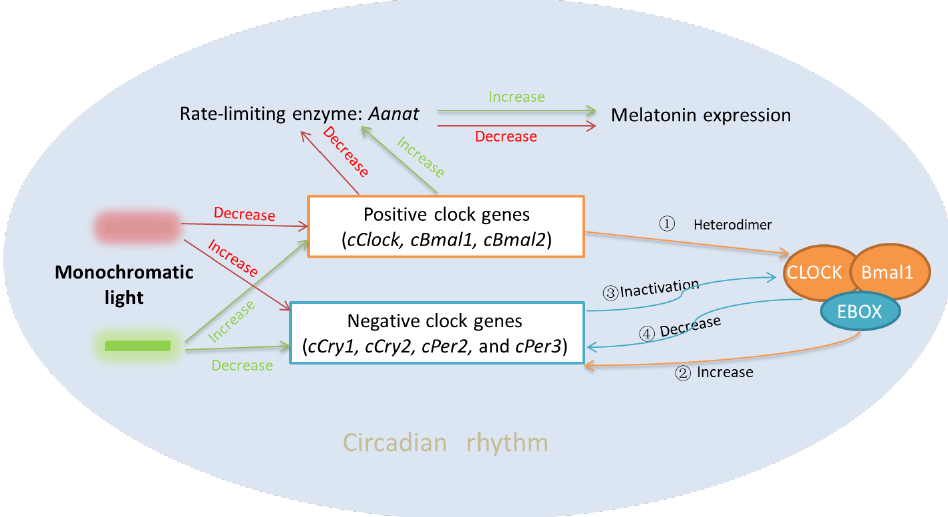
Figure 6. Monochromatic light affects melatonin expression and negative feedback of transcription– translation.